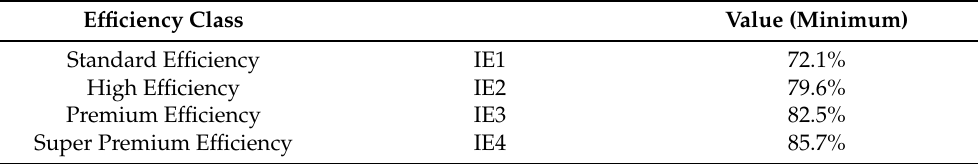
Table 2. Minimum 50 Hz efficiency values defined in IEC/EN 60034-30-1:2014 for a four-pole/1.0 HP